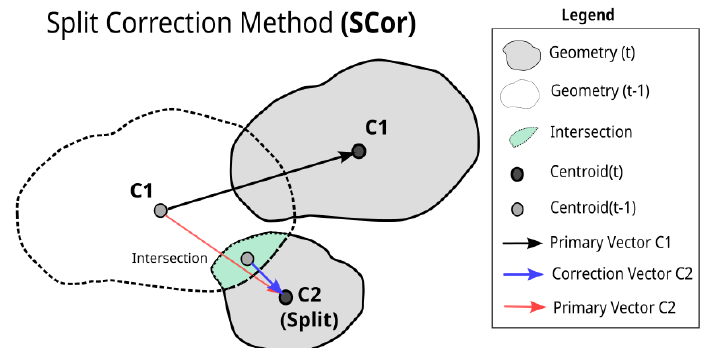
Figure 4. Schematic for the Split Correction method. The green polygon is the intersection geometries for the New Split rain cell. The arrows indicate the displacement vectors used in the SCor method, where the red arrow is the vector used for the adjustment and the blue arrow is the displacement vector adjusted by the method.